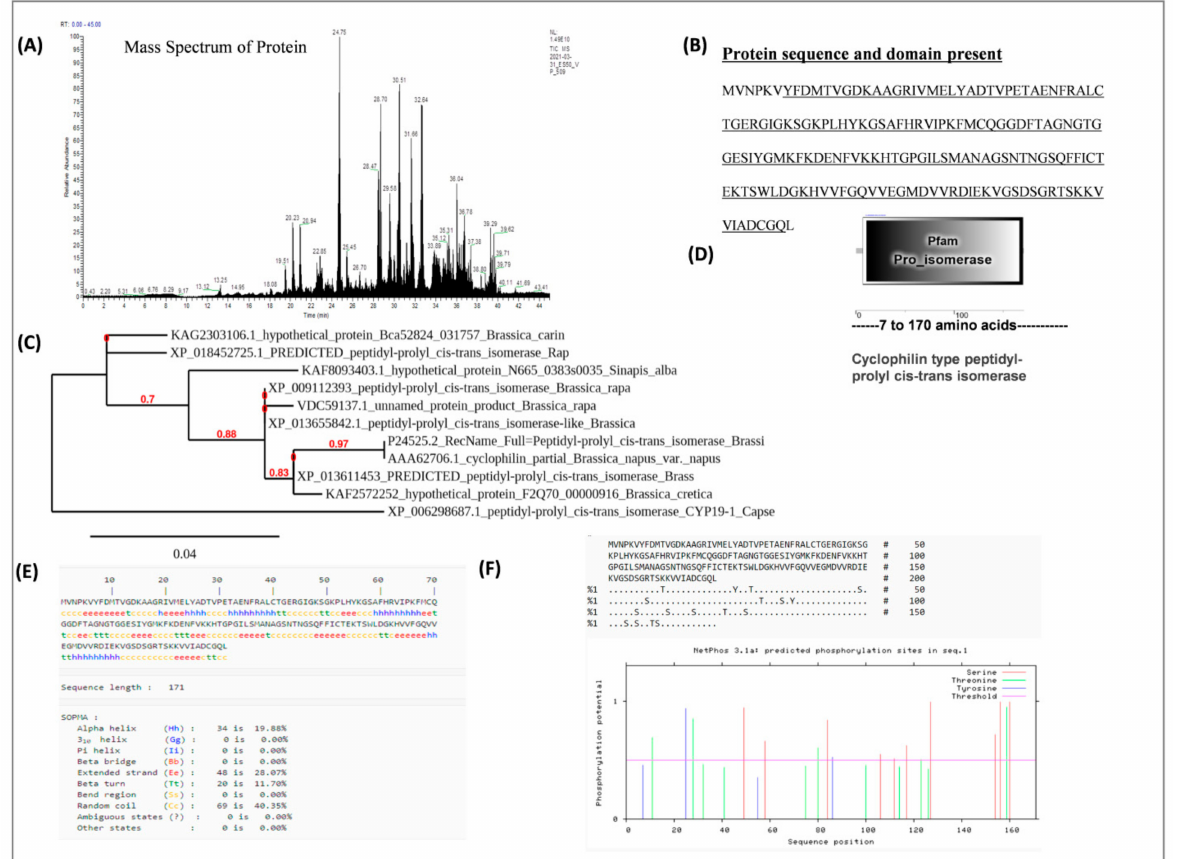
Figure 5. Physicochemical property of PPIase: ( A ) Mass spectrum of protein obtained by sequencing of protein ( B ); amino acid composition of protein ( C ); phylogenetic analysis: Multiple sequence alignment and phylogenetic tree of the deduced amino acid sequence of the PPIase protein with the homologous proteins from other plant species including Brassica. Both the analysis performed using clustal W software with default parameters. ( D , E ) Domain analysis and secondary structure prediction andphosphorylation sites in protein structure ( F